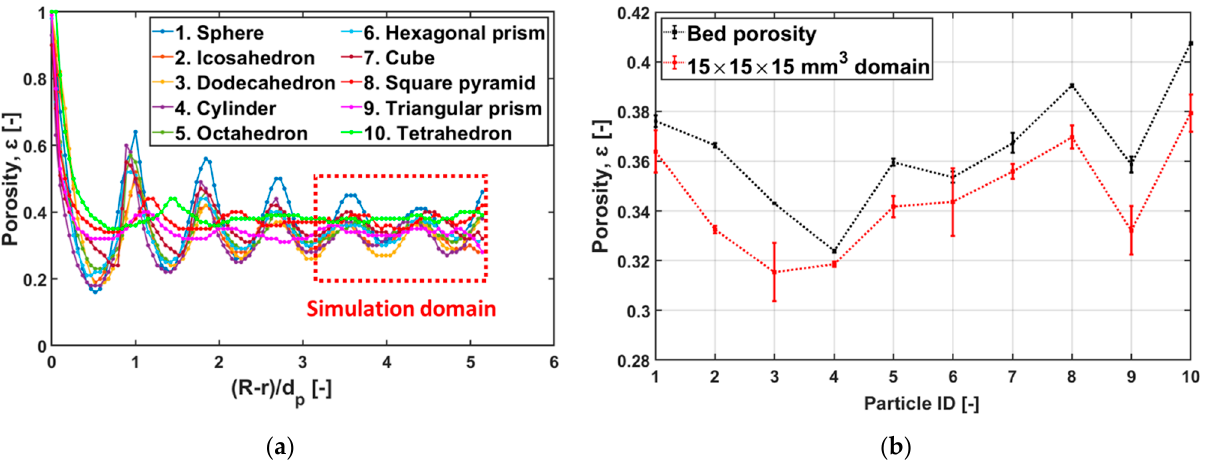
Figure 3. Porosities for different particle shapes: ( a ) radial porosity profiles, red-dotted lines repre- sent the domain considered for thermal simulations and ( b ) comparison of bed and simulation domain porosities.